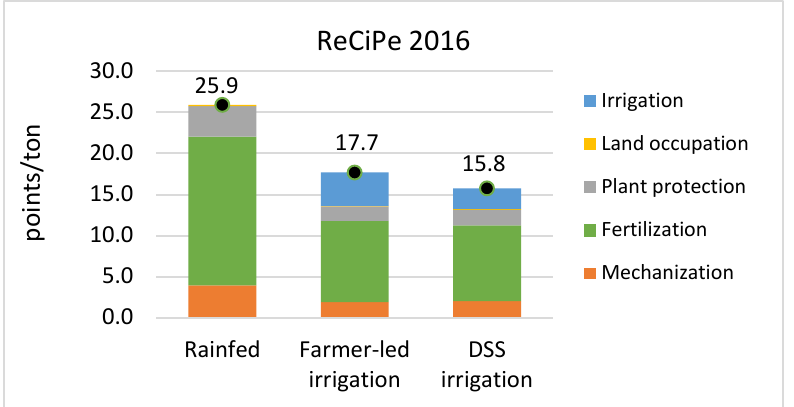
Figure 7. Process contribution to the overall environmental impact of olive cultivation as single score (points) using EF 3.0 (adapted) and ReCiPe 2016 life cycle assessment methods.